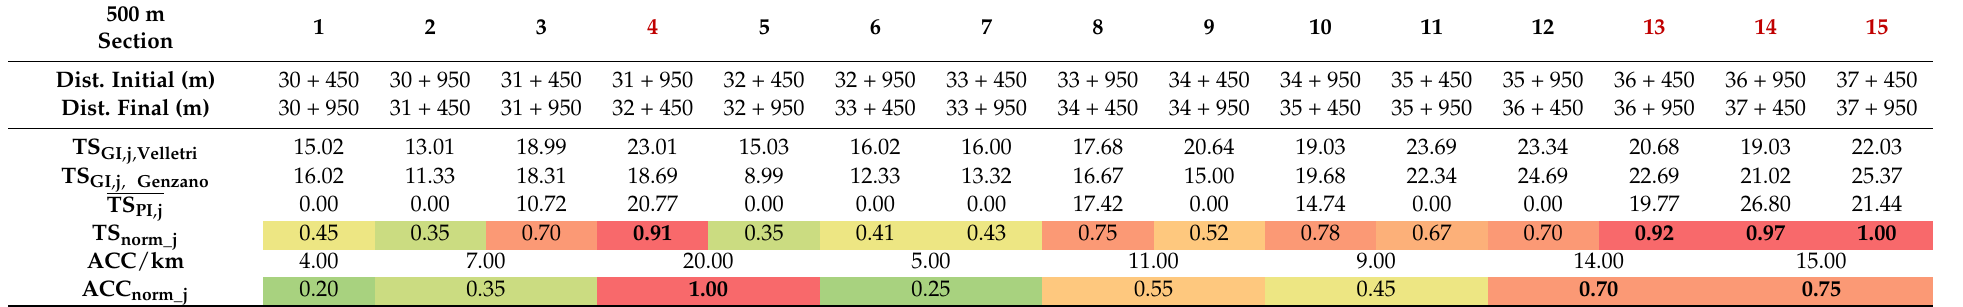
Table 4. A summary of the outcomes of the inspection